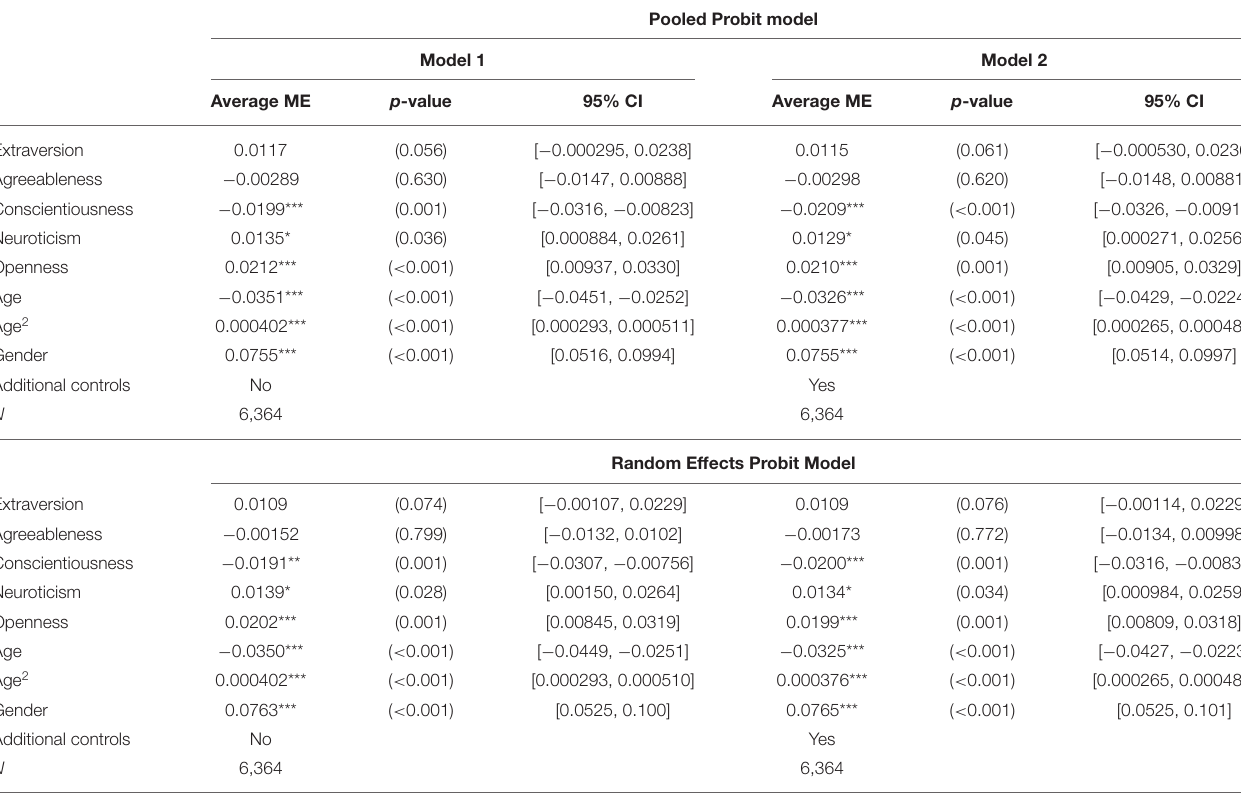
TABLE 9 | Big Five personality dimensions and privately motivated non-formal further training